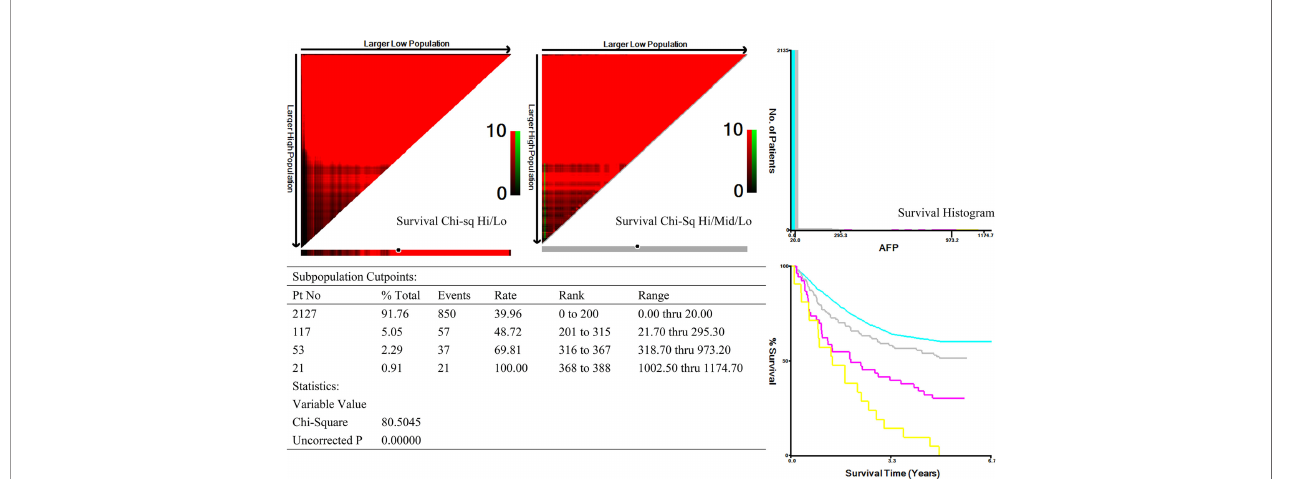
FIGURE 3 | X-tile analysis of overall survival according to serum AFP values.